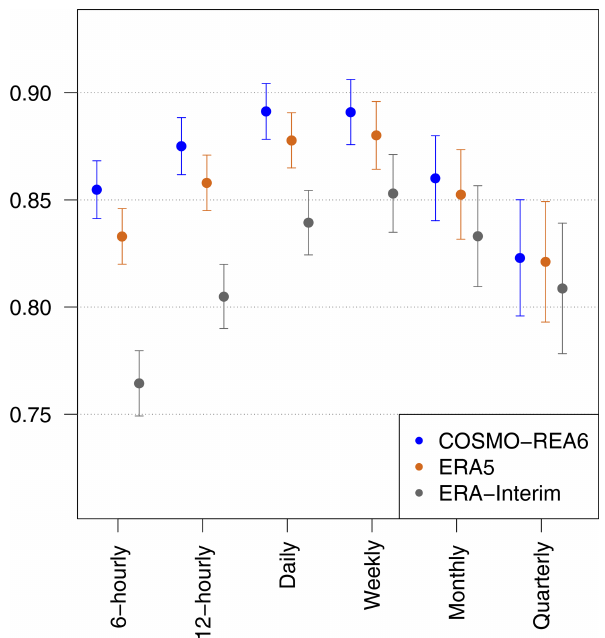
Figure 2. Correlation of wind speed of various reanalysis datasets with near-surface wind speed measurements recorded by German stations: Time dependence of the Pearson correlation coefficient av- eraged over 128 German locations above 100m station height for COSMO-REA6 and the two global reanalyses ERA5 and ERA- Interim derived from the time period January 1995–August 2019. Averages are based on reanalysis and observational data sampled every hour, except for the 6h ERA-Interim analysis. The error bars mark the 95% confidence interval extracted from the sample of sta- tions. The figure was produced in analogy to Fig. 1b of Niermann et al. (2019), but for a longer period and additionally contains ERA5. Locations above 100m station height have been chosen, because wind measurements from these stations have not been assimilated in the production of